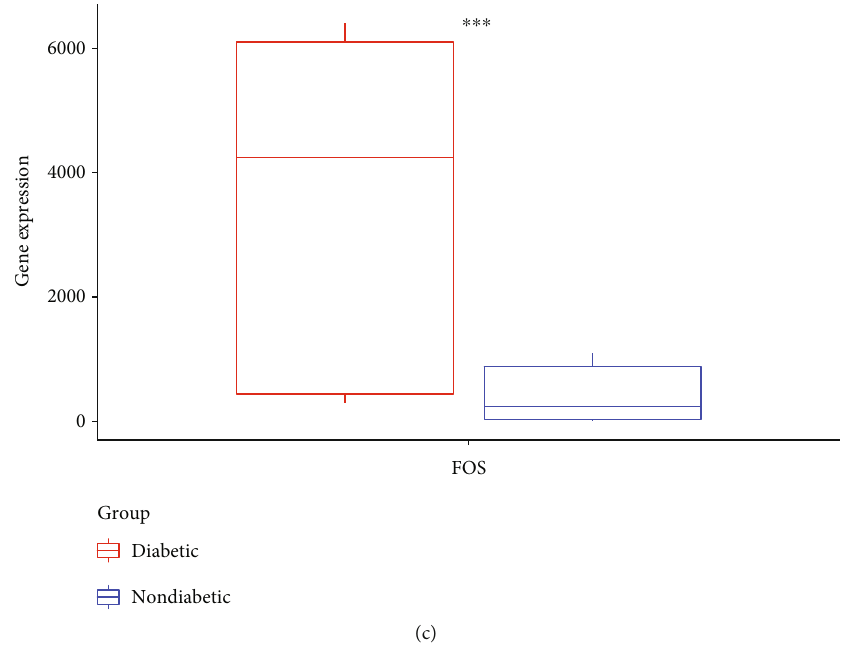
Figure 9: (a) IL-6. (b) AKT1. (c)